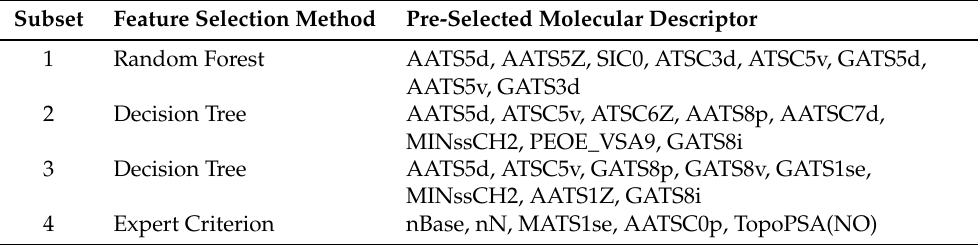
Table 1. Four subsets of descriptors selected for the model based on structural similarity.